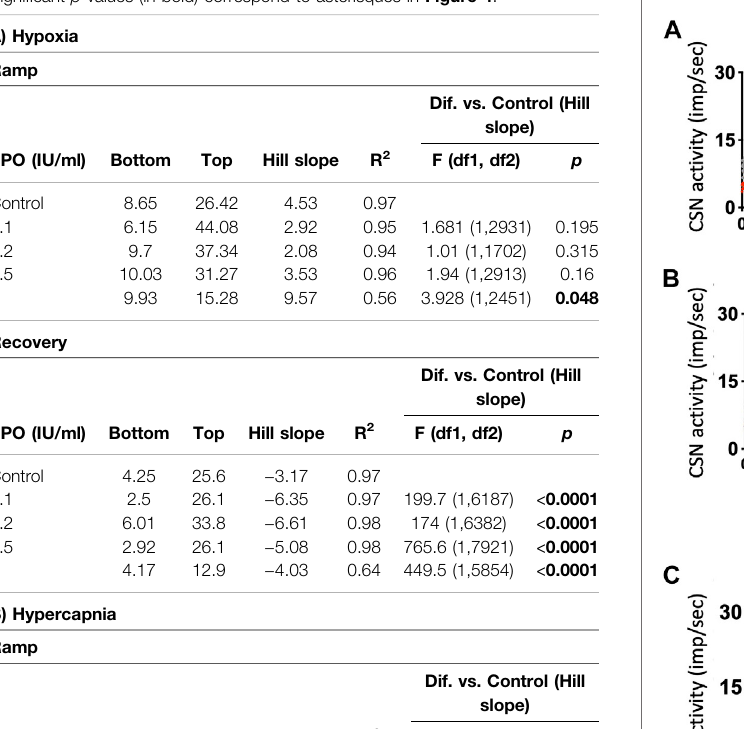
TABLE 1 | Effect of stimuli on the response of the carotid body during the ramp and recovery phases evaluated by comparing the Hill slopes for each curves. Signi fi cant p values (in bold) correspond to asterisques in Figure 4 .